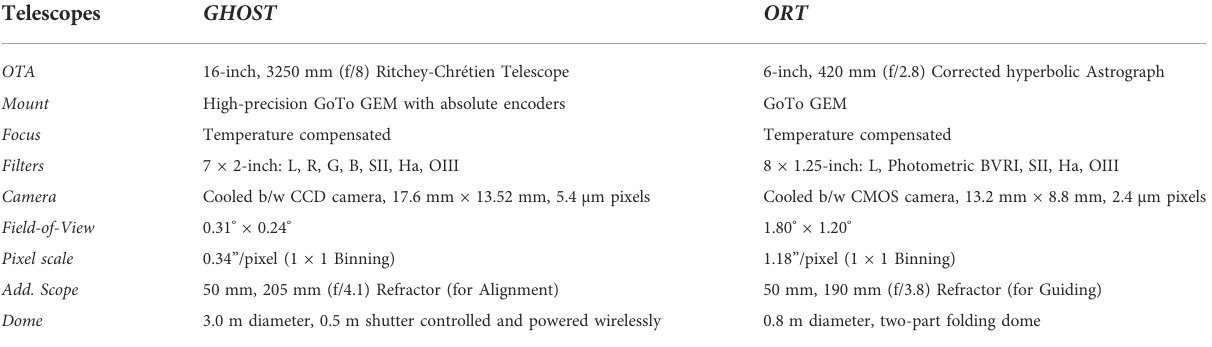
TABLE 1 Components and speci fi cations of the telescopes “ GHOST ” and “ ORT ” of the University Observatory of Oldenburg (MPC Code: G01).